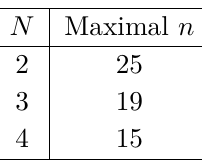
Table 2 . The maximal n of comprehensive cohomological enumeration for each N